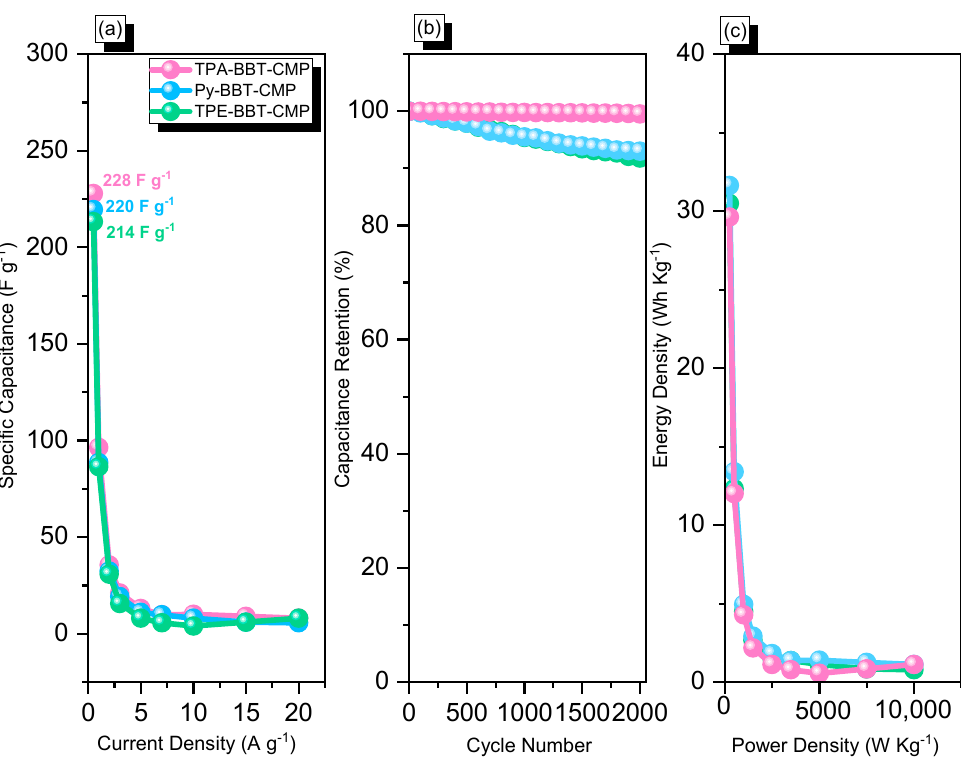
Figure 5. Capacitance ( a ), stability ( b ), and Ragone plots ( c ) of TPA–BBT–CMP, Py–BBT–CMP, and TPE–BBT–CMP.